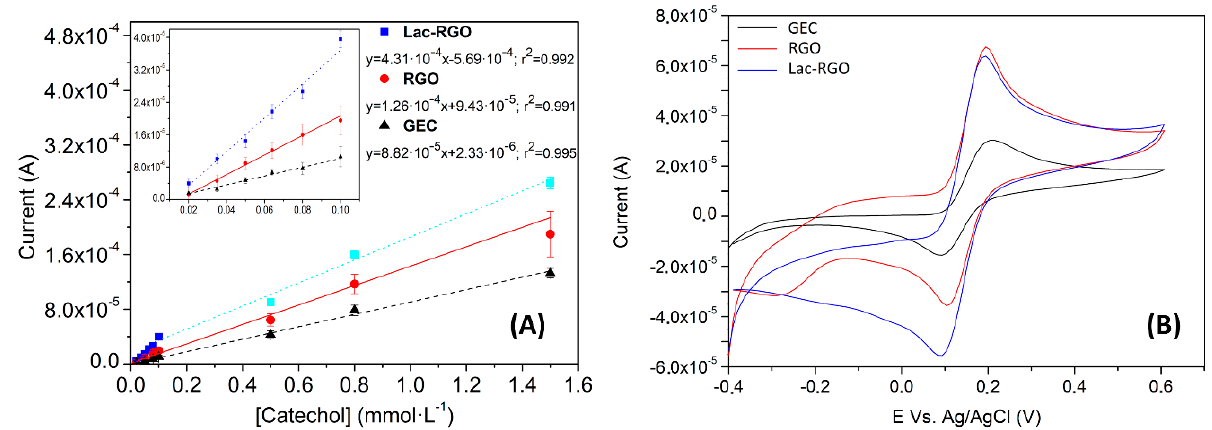
Figure 7. ( A ) Calibration curves for Lac-RGO electrode ( ∎ ), RGO electrode ( ● ) and GEC electrode ( ▲ ) for the same concentrations of catechol. Currents for the oxidative peak ( B ) CV voltammograms response of the three electrodes in the same concentration of catechol. Measures in phosphate buffer + KCl solution, pH 7.4.